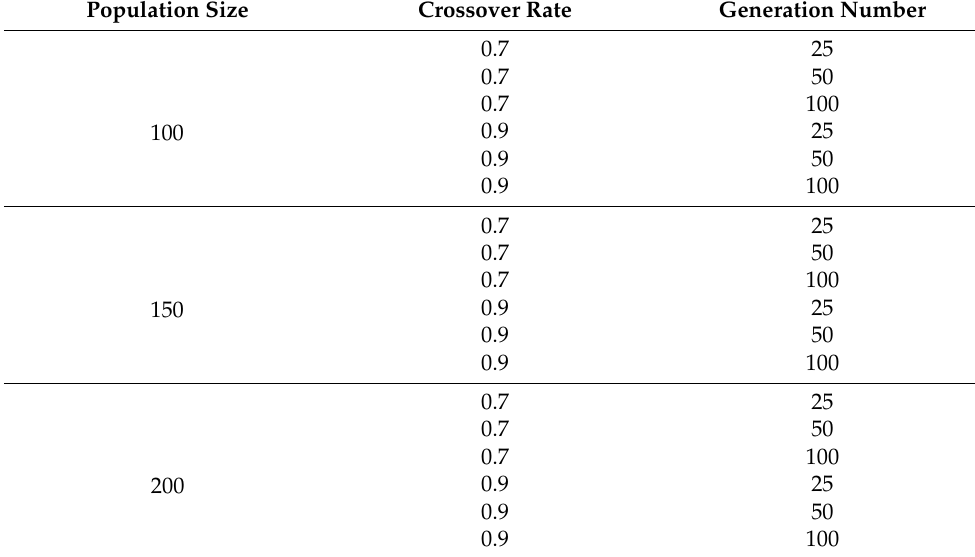
Table 2. Optimization model parameter sets.